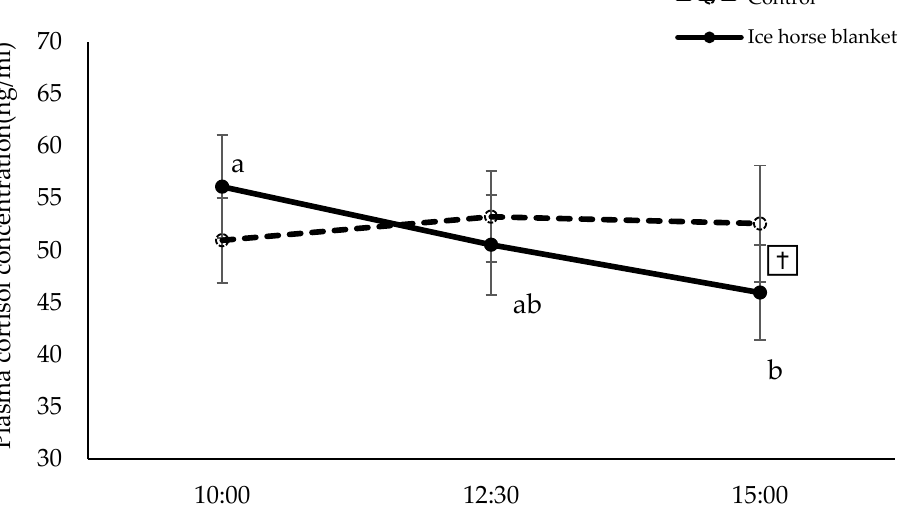
Figure 5. Plasma cortisol concentration. Values are expressed as mean ± SE. Significant differences between C and IB at same time point are represented by asterisk (* p < 0.05) and tendency between C and IB at same time point are represented by dagger († p < 0.1). Significant differences between each time point within group are represented by different letters ( ab p < 0.05).